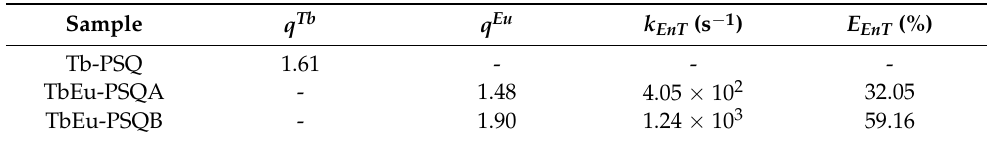
Table 2. Hydration state of Tb 3+ ( q Tb ) and Eu 3+ ( q Eu ) ions, and Tb 3+ → Eu 3+ energy transfer rate ( k EnT ) and efficiency ( E EnT ) parameters of Tb-PSQ, TbEu-PSQA and TbEu-PSQB samples.